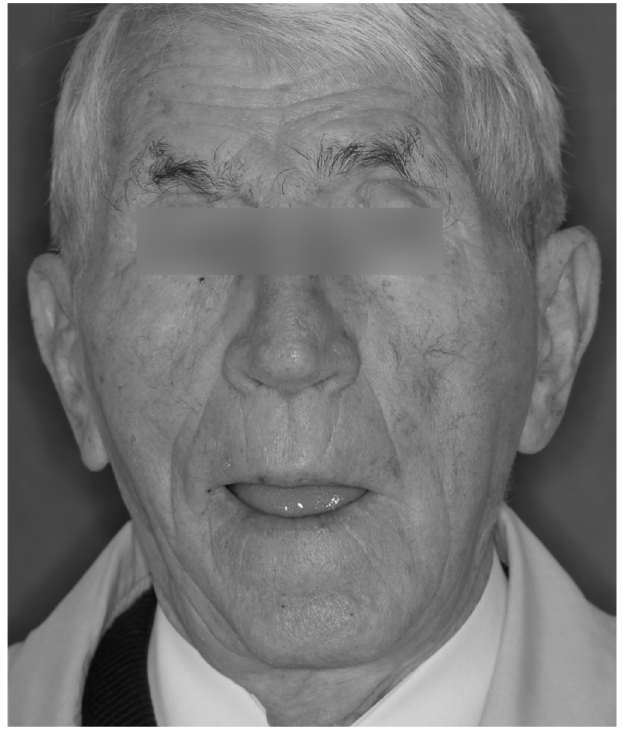
Figure 1. Patient presenting mouth restriction to 10 mm.